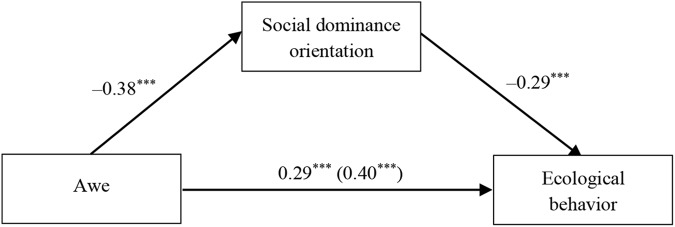
Mediation model for Study 1. ∗∗∗p < 0.001.